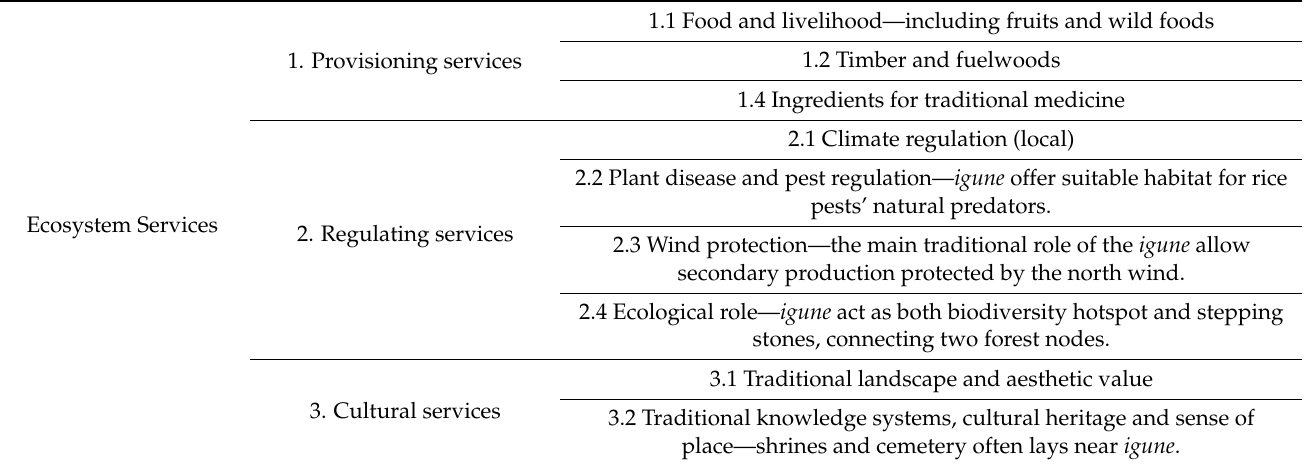
Table 5. List of Ecosystem Services provided by igune and other small woods within the study area. The Ecosystem Services classification is based on the Millennium Ecosystem Assessment